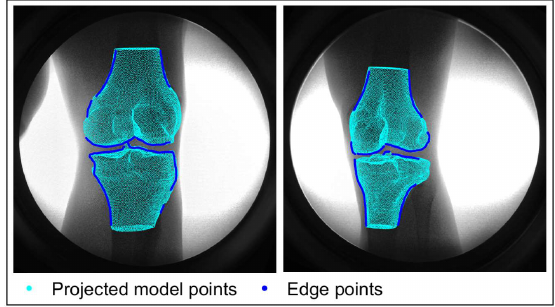
Figure 9. Registration result for at a single